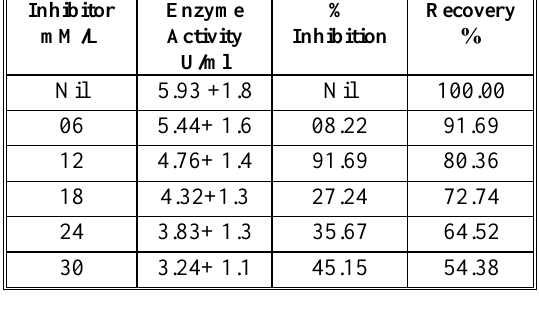
Table(3) :In vitro inhibition of human serum cholinesterase by different concentrations of Gallic acid.